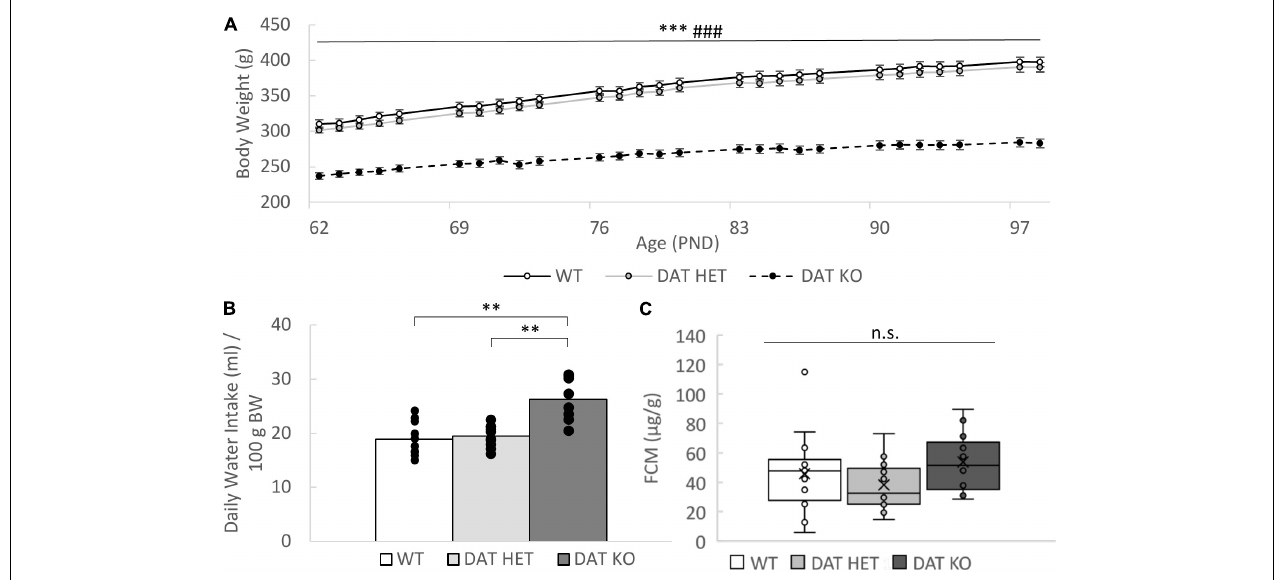
FIGURE 4 | (A–C) Physiological Parameters. (A) Body Weight. Development of the body weight during the experiment. The DAT KO rats had a significant lower body weight throughout the experiment. Data shown are expressed as the mean. Sample size: DAT KO ( n = 16), DAT HET ( n = 20), WT ( n = 20). PND, postnatal day. (B) Water Intake. Bars illustrate the mean daily water intake per 100 g body weight measured weekly (Saccharin preference test week was excluded). The dots indicate all elevated data points included. The DAT KO rats drink significantly lower amounts of water compared to the other genotypes. Sample Size: DAT KO ( n = 7), DAT HET ( n = 9), WT ( n = 8). (C) Fecal corticosterone metabolite (FCM) concentration. Boxplots showing the FCM concentrations for the three genotypes. No genotype effect was observed. Sample size: DAT KO ( n = 13), DAT HET ( n = 13), WT ( n = 15). (A–C) ∗∗ p < 0.01, ∗∗∗ p < 0.001 between HET and KO, ### p < 0.001 between WT and